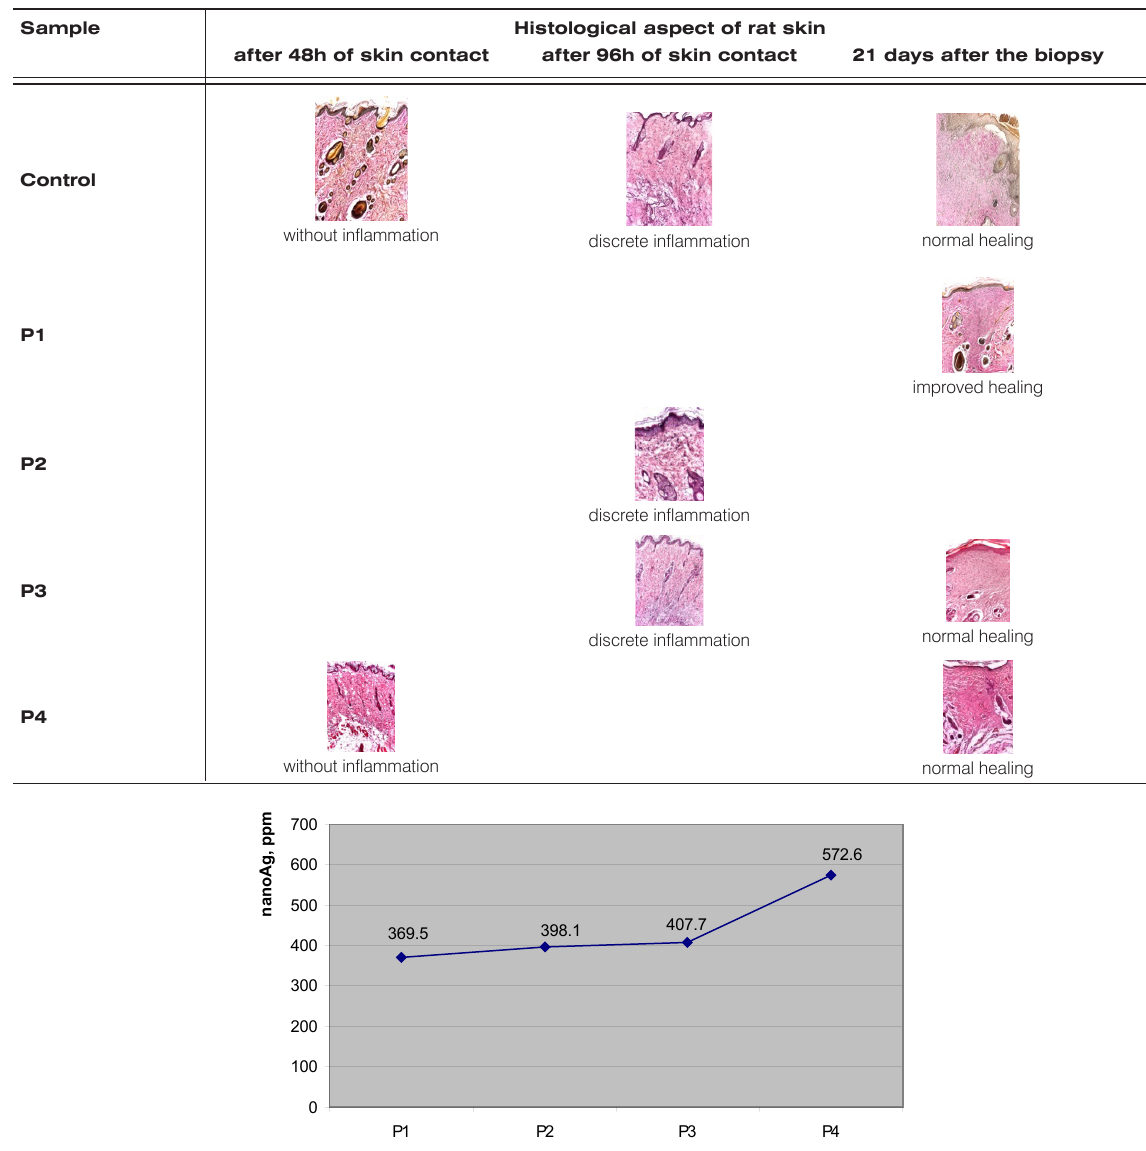
Figure 10. The concentration of AgNPs in the wool of four sheepskin samples.